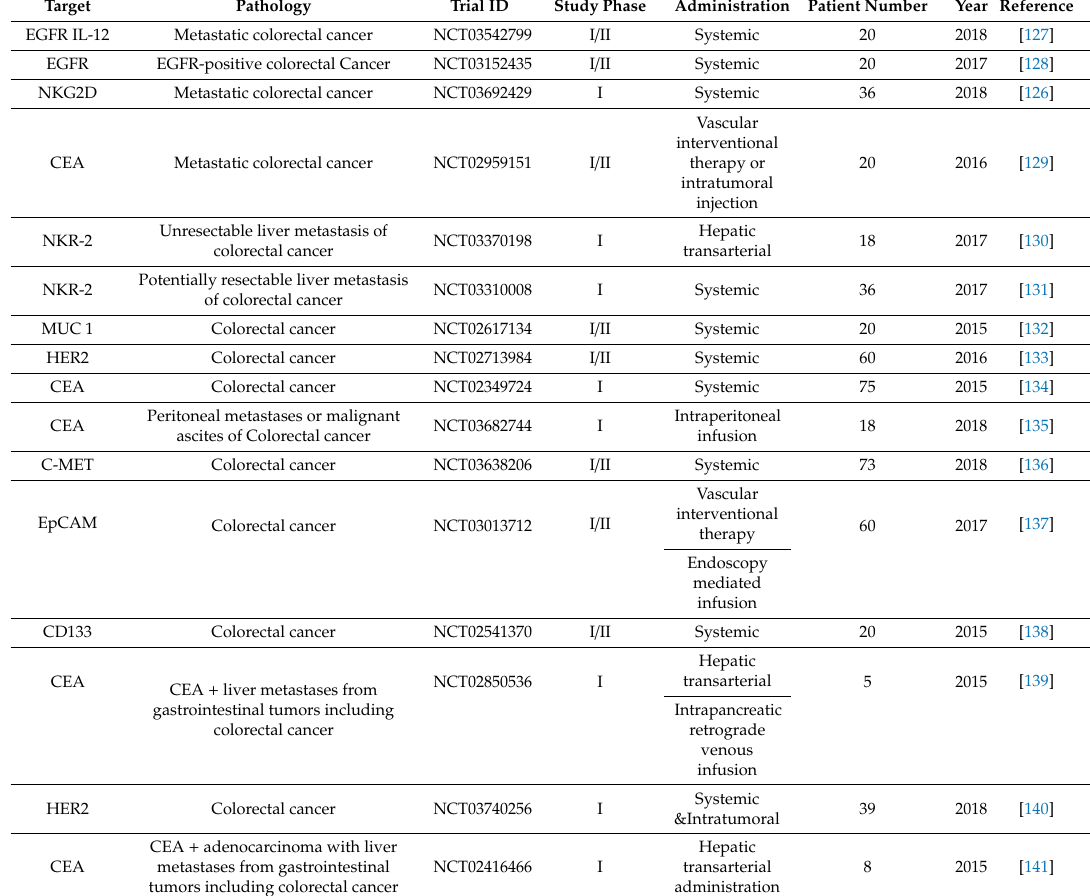
Table 1. Ongoing clinical trials of CAR T-cell therapy conducted in